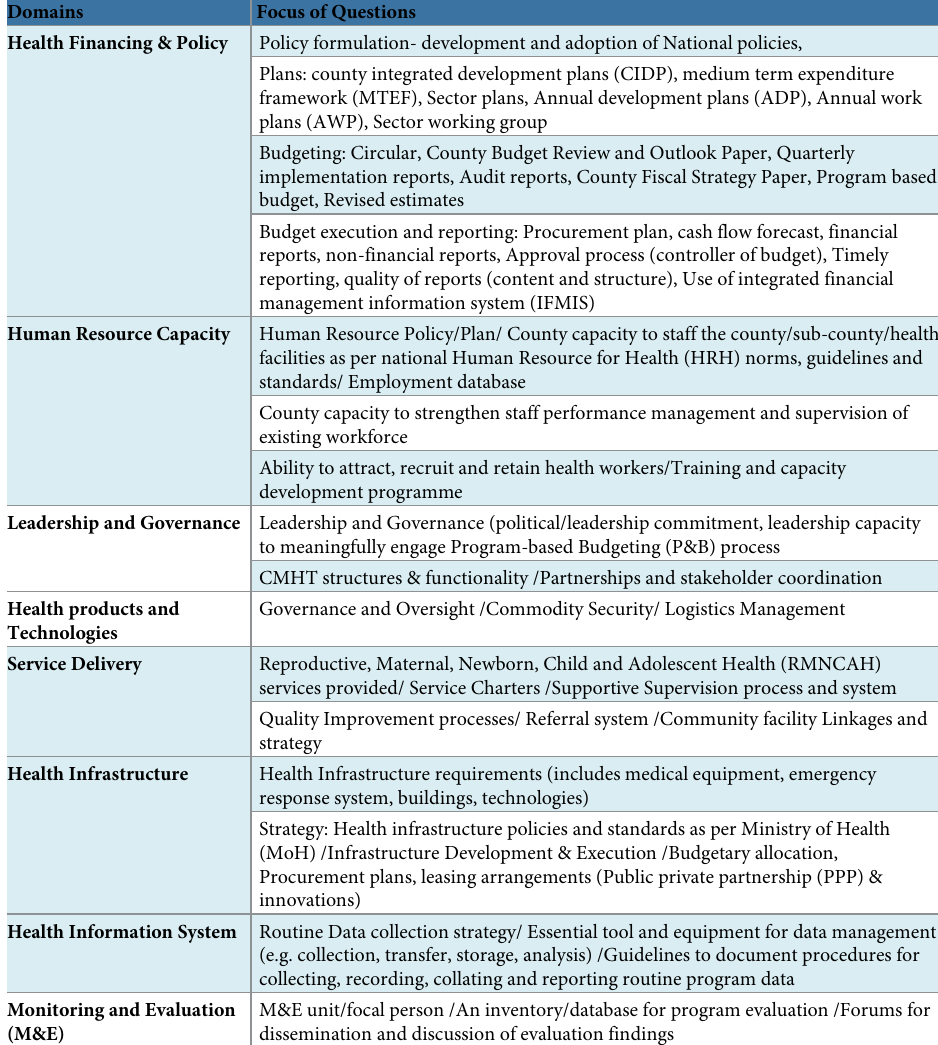
Table 1. Summary of domains